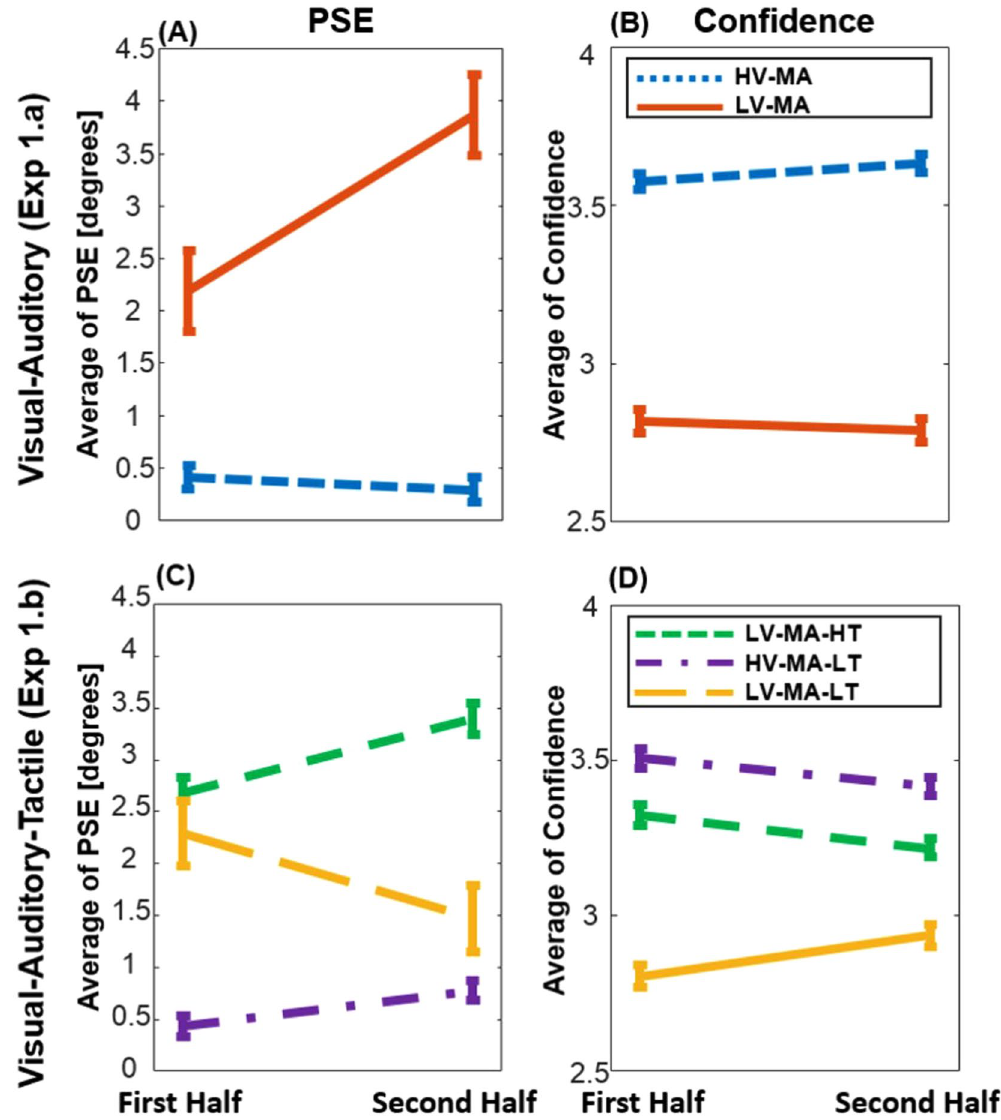
Figure 3. PSE variations as well as confidence changes between the first and the second half of each section across different reliability conditions. The error bars were computed by the method described in ref. 34 and show ± 1SE. ( A ) PSE variation in the visual-auditory section: The PSE was shifted toward the auditory location in the LV-MA condition, while it remained close to the visual location in the HV-MA condition. ( B ) Confidence alteration in the visual-auditory section: there was no significant change in the confidence, however the confidence in the HV-MA condition is significantly higher than in the LV-MA. ( C ) PSE variation in the visual-tactile-auditory section: the PSEs in the HV-MA-LT and the LV-MA-HT conditions moved toward the tactile location significantly. Nevertheless, it was not significant in the LV-MA-LT condition (yellow line). ( D ) Confidence alteration in the visual-tactile-auditory section: All confidence ratings changed significantly, a significant increase in the LV-MA-LT condition, and significant decrease in the HV-MA-LT and the LV-MA-HT